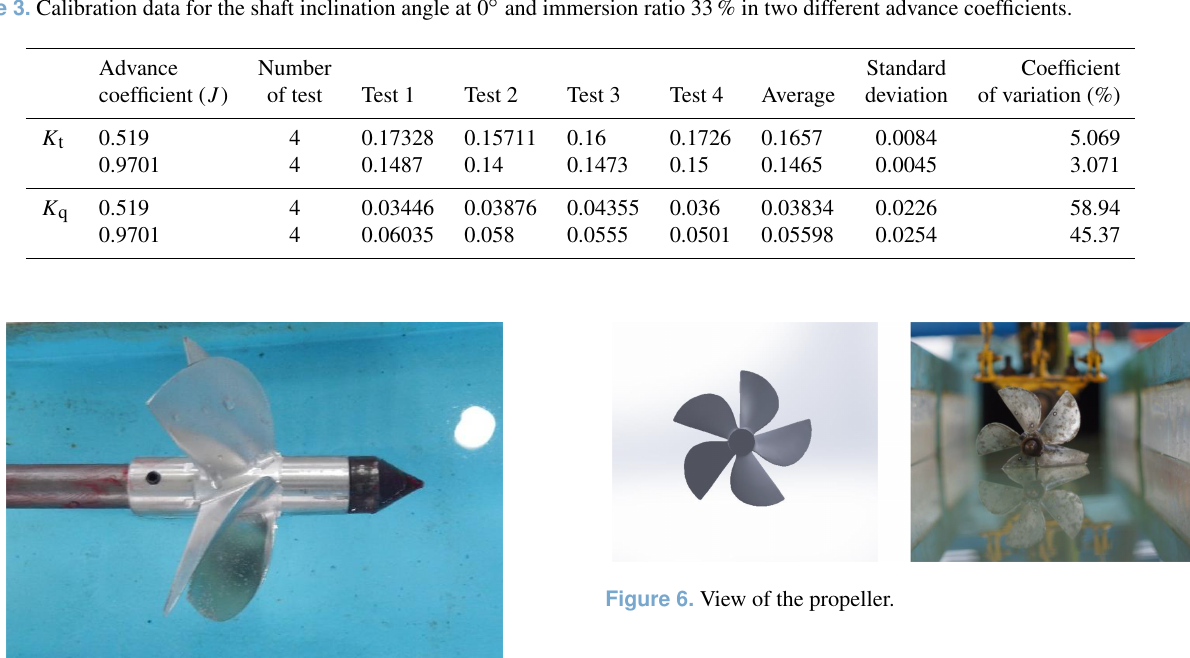
Table 3. Calibration data for the shaft inclination angle at 0 ◦ and immersion ratio 33% in two different advance coefficients.